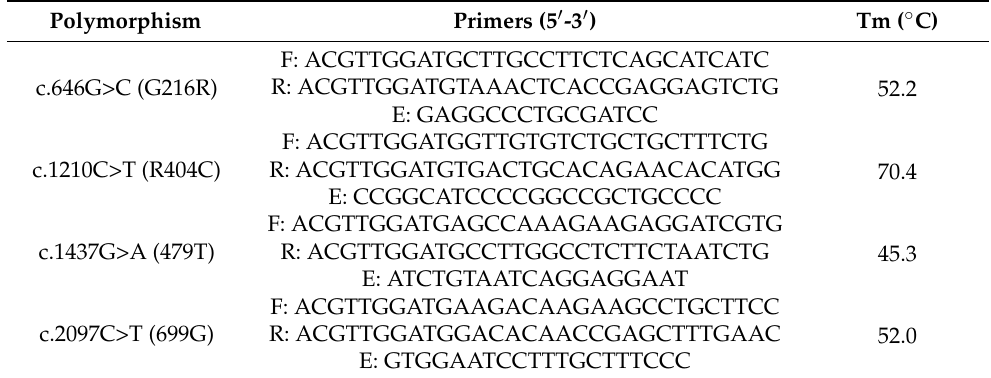
Table 2. Primer sequence information of the variant locus of the CAST